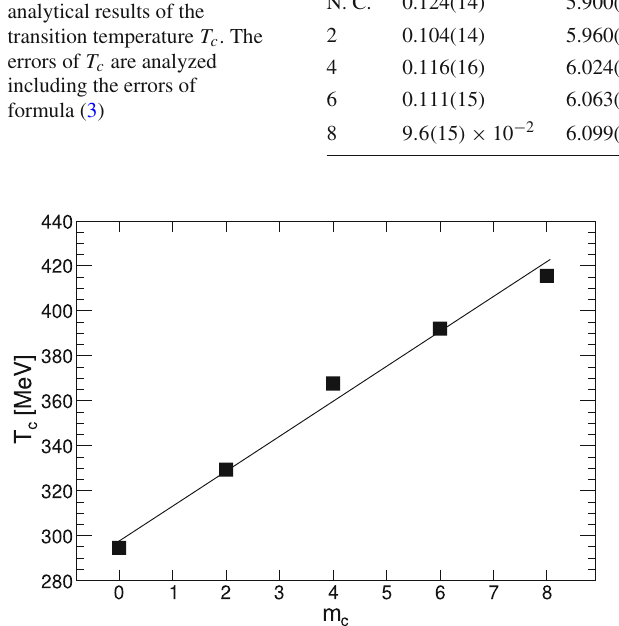
Table 4 The fitting results of the Polyakov loop susceptibility χ by the curve (8) and the analytical results of the transition temperature T c . The errors of T c are analyzed including the errors of